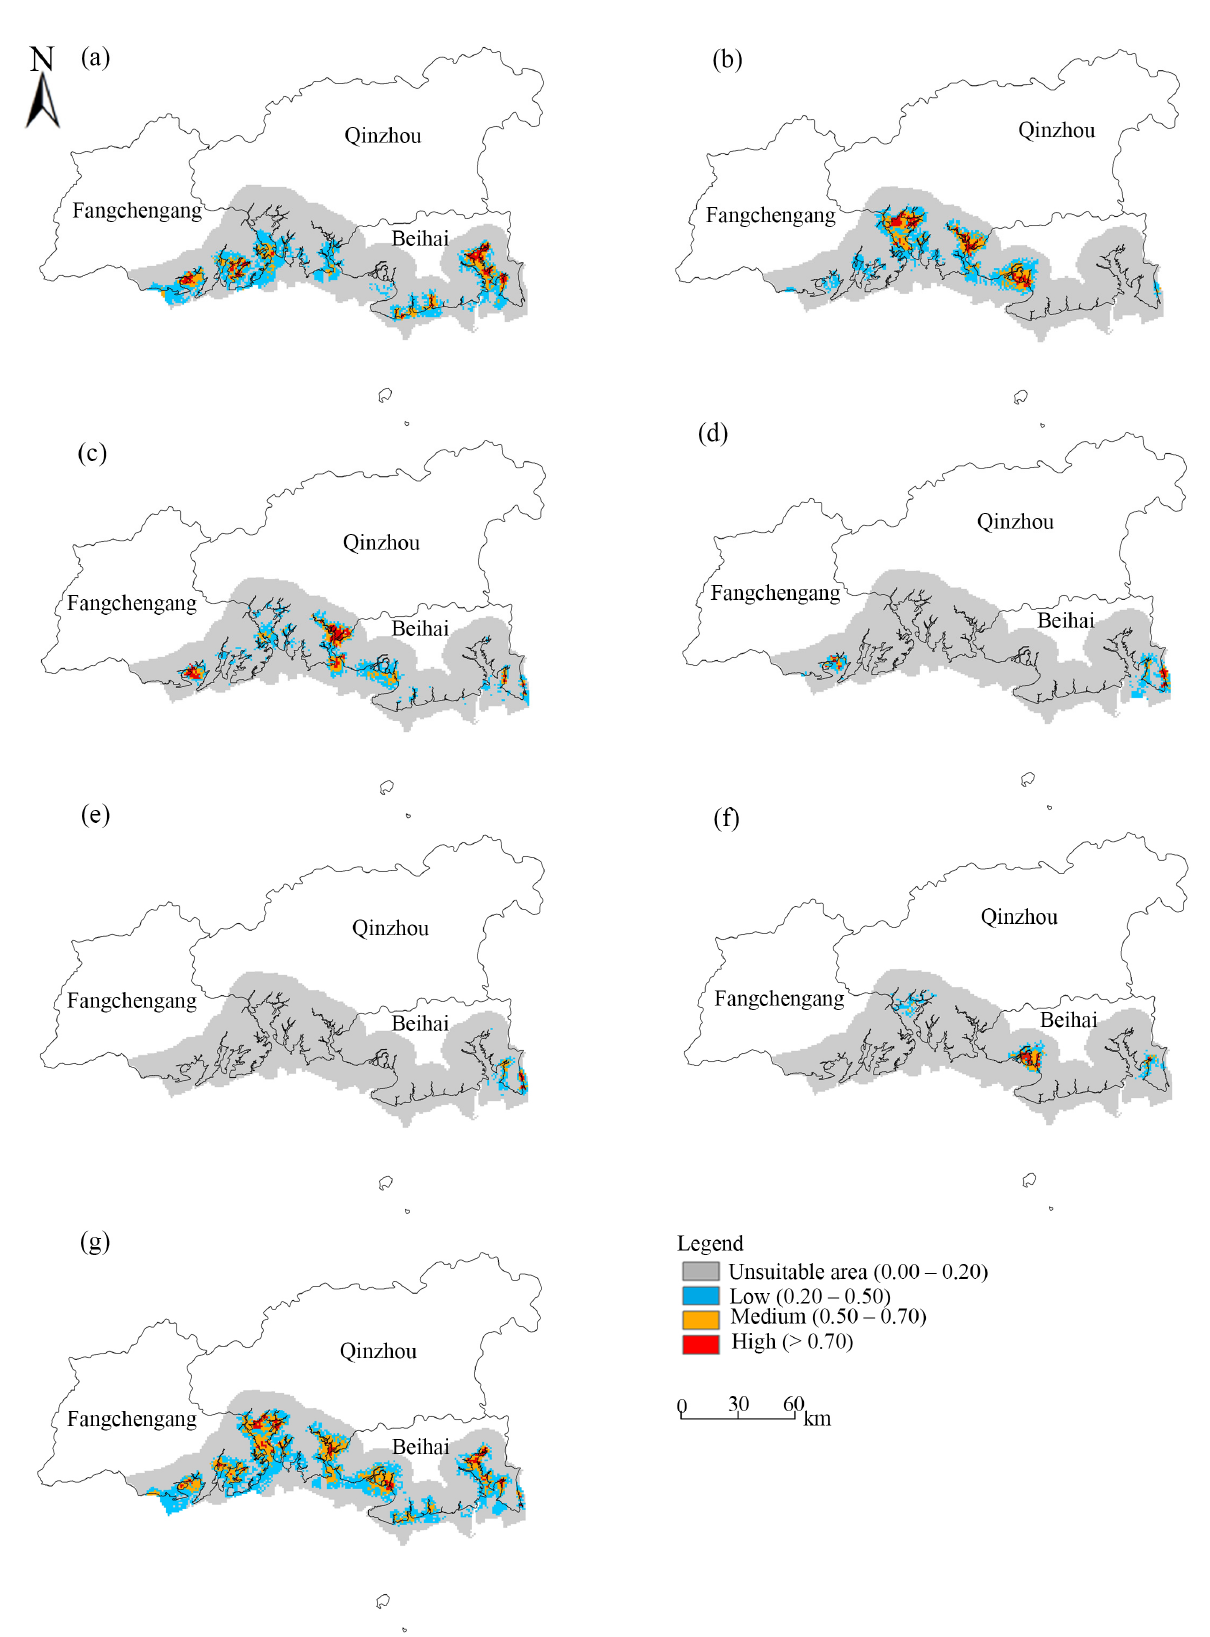
Figure 13. Distributions of suitable mangrove habitats in the Beibu Gulf. ( a ) A. marina , ( b ) A. corniculatum , ( c ) K. obovata , ( d ) B. gymnorrhiza , ( e ) R. stylosa , and ( f ) A. ilicifolius ( g ) Overall mangrove community